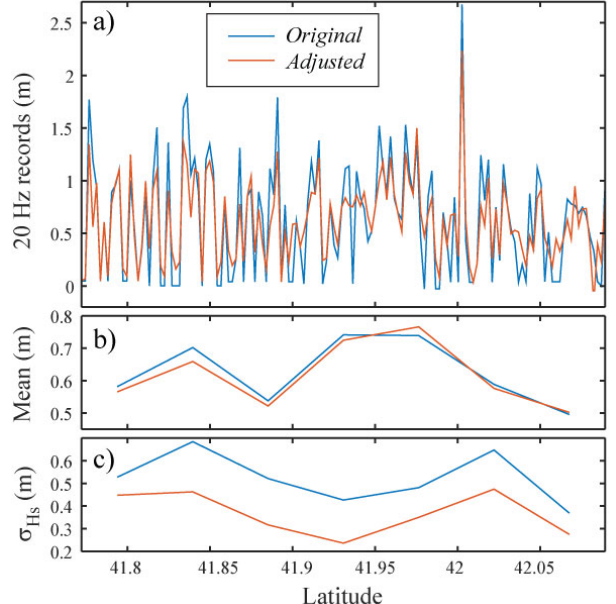
Figure 5. Effect of implementing adjustment. ( a ) Short example section (7 secs) showing variability in original Jason-3 MLE-4 Hs estimates, and in that of the adjusted estimate. ( b ) Mean Hs values at 1 Hz. ( c ) Variability (S.D.) within each 1-second